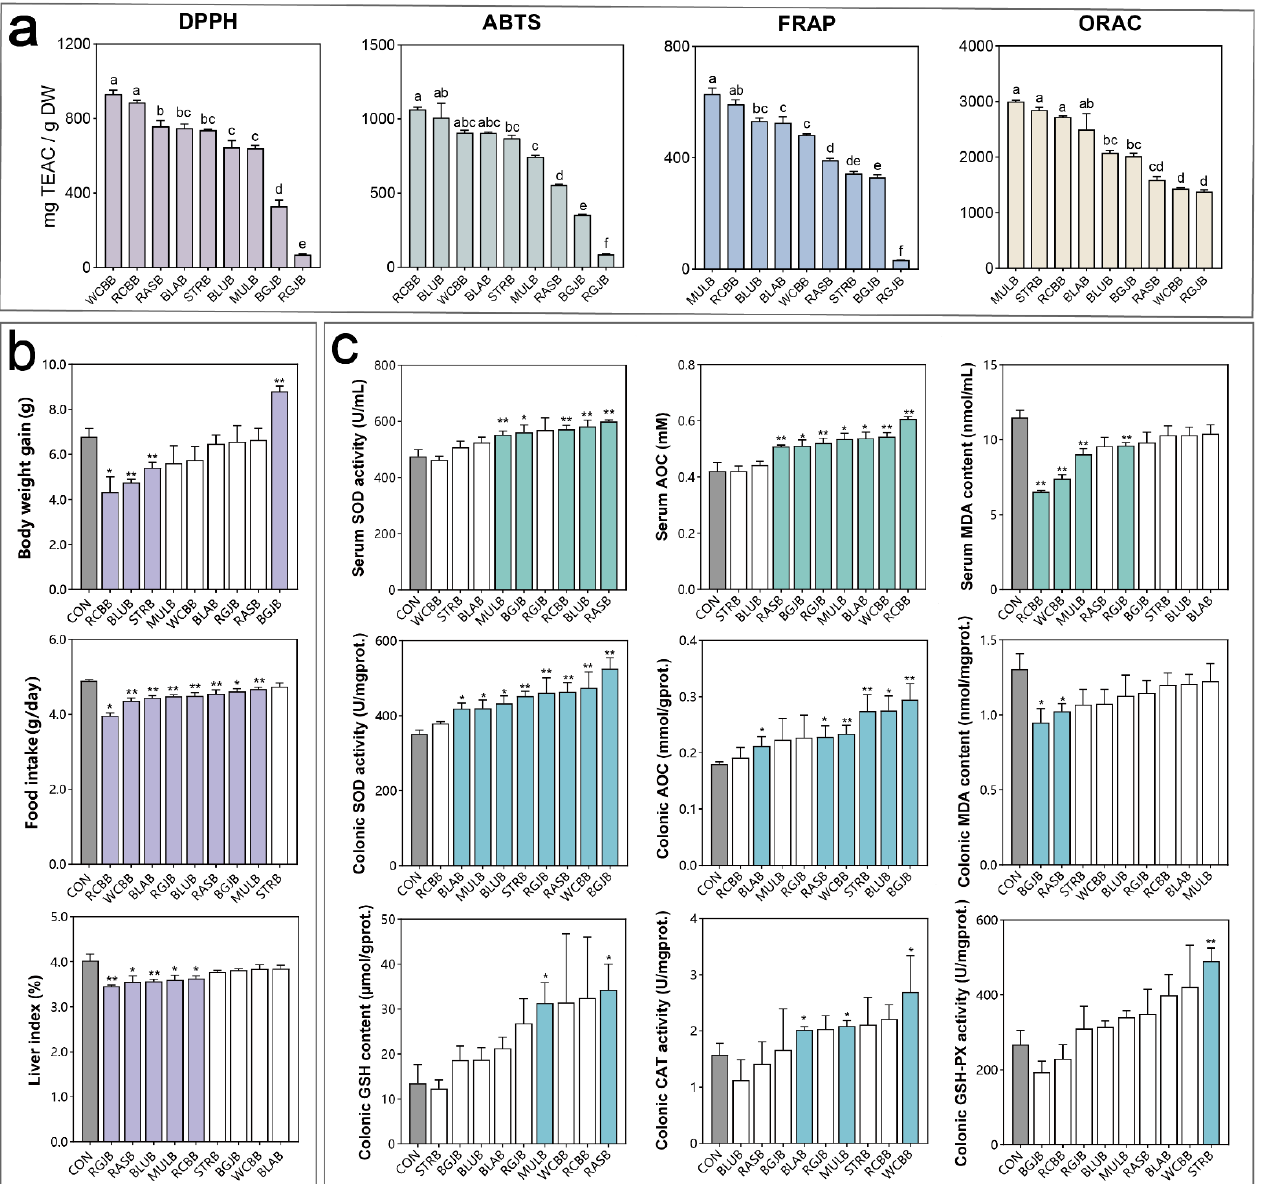
Figure 2. Evaluation of in vitro and in vivo antioxidant capacities of different kinds of berries. ( a ) Antioxidant capacities evaluation of different kinds of berry extract based on DPPH, ABTS, FRAP and ORAC. All samples were analyzed in triplicate. Error bars were expressed as mean ± SEM. Statistical significance was determined by one-way ANOVA with Turkey tests for multiple-group comparisons. Different letters mean significant difference between the groups ( p < 0.05). ( b ) Influence of berry extracts on the physical condition and ( c ) antioxidant capacities of healthy objects. Error bars were expressed as mean ± SEM (n = 7/group). Statistical significance was determined by Mann-Whitney U test for